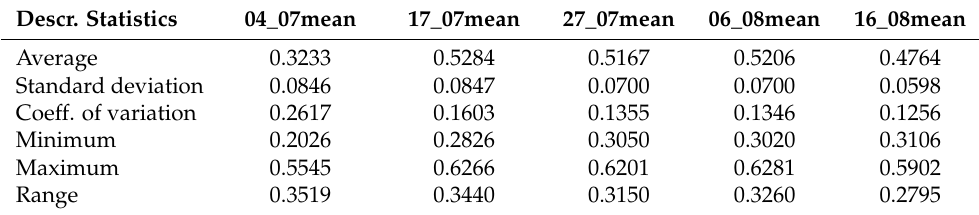
Table 6. The descriptive statistics of the GNDVI mean values across all pilot fields during each data collection date.